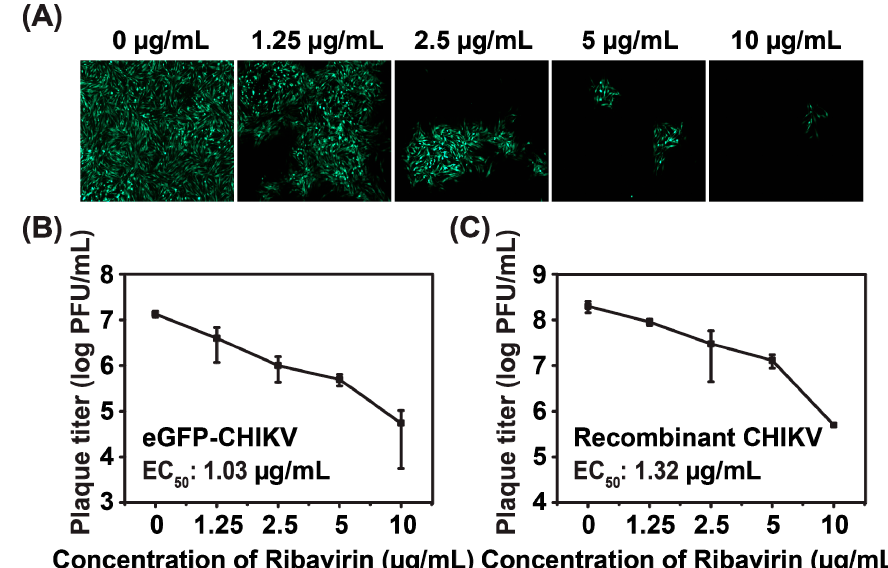
Figure 5. Antiviral activity of ribavirin on eGFP-CHIKV reporter viruses. ( a ) detection of eGFP expression by fluorescent microscope at different concentrations of ribavirin; ( b ) viral titer reduction assay of CHIKV with different concentrations of ribavirin. BHK-21 cells were infected with eGFP-CHIKV at MOI of 0.05 and treated with various concentrations of ribavirin. The viral titers were quantified by plaque assay at 48 hpi; and ( c ) viral titer reduction assay of WT CHIKV at different concentrations of ribavirin. The experiments were performed in triplicate, and the representative data were presented.